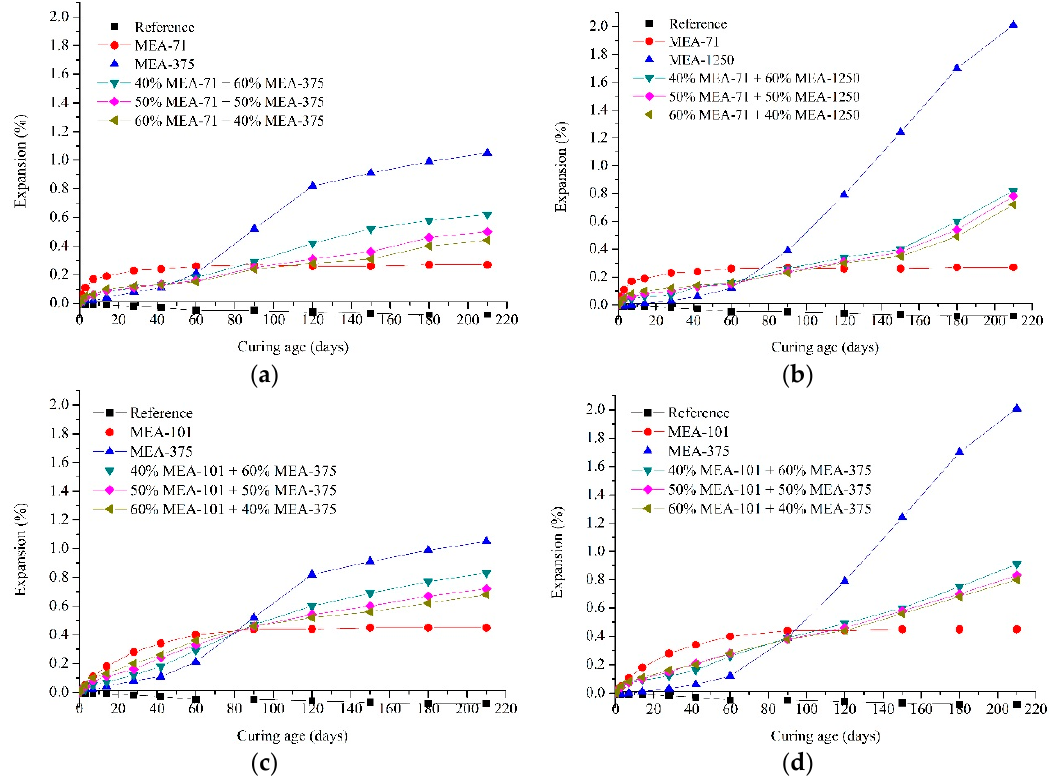
Figure 11. Expansion curves of cement pastes containing 8 wt % of blended MEAs cured in water at 40 °C: ( a ) MEA71 + MEA-375, ( b ) MEA-71 + MEA-1250, ( c ) MEA-101 + MEA-375, ( d ) MEA-101 + MEA-1250.